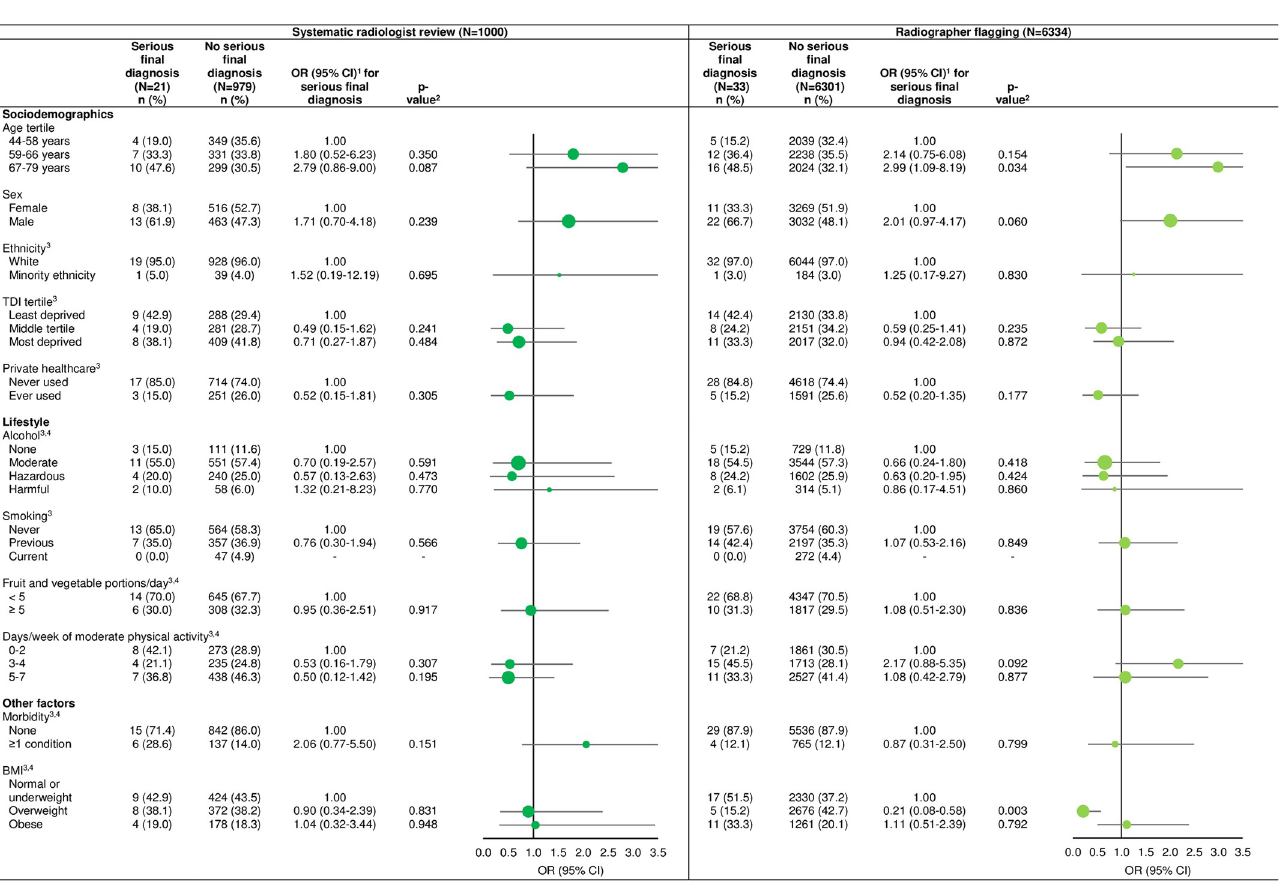
Fig 3. Age- and sex-adjusted odds ratios for serious final diagnoses stratified by PSIFs protocol. OR = odds ratio, CI = confidence interval, TDI = Townsend Deprivation Index, BMI = body mass index. Circles are weighted by the proportion of participants within a category. 1. Age- and sex-adjusted ORs, except age tertiles which are adjusted for sex only, and sex which is adjusted for age only. 2. p-value from Wald test. 3. Data were missing as described in Fig 2, footnote 3. 4. We calculated alcohol intake, fruit and vegetable intake, physical activity, morbidity and BMI as described in the footnotes to Table